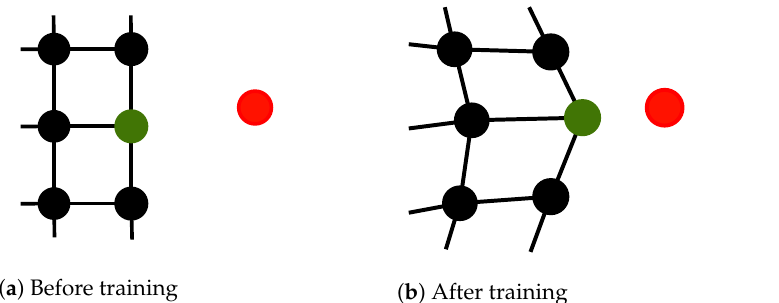
Figure 3. Training the SOM on a new input sample ( red ). The best-matching unit ( green ) is affected the most, while the neighboring nodes are less influenced. The distance between the nodes is proportional to the similarity in the data space.